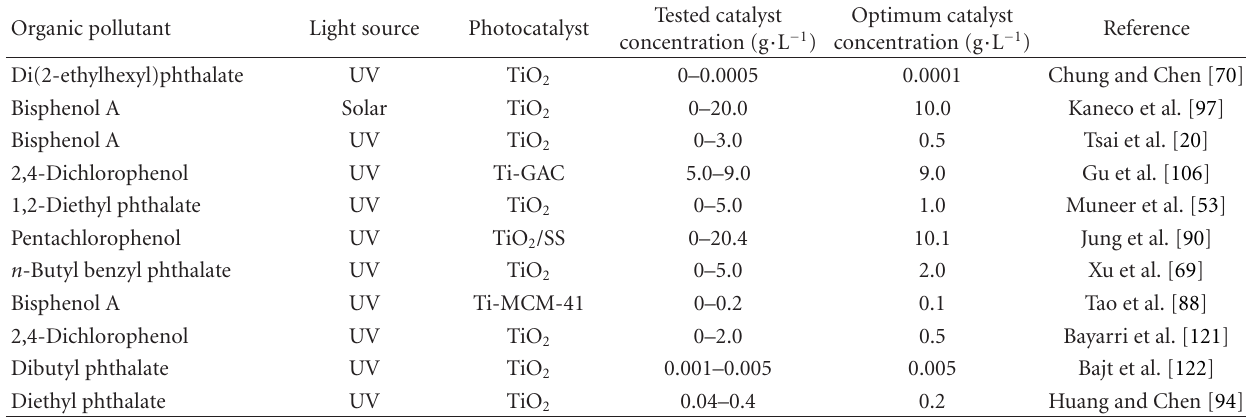
Table 2: E ff ect of catalyst loading on the photocatalytic degradation of various